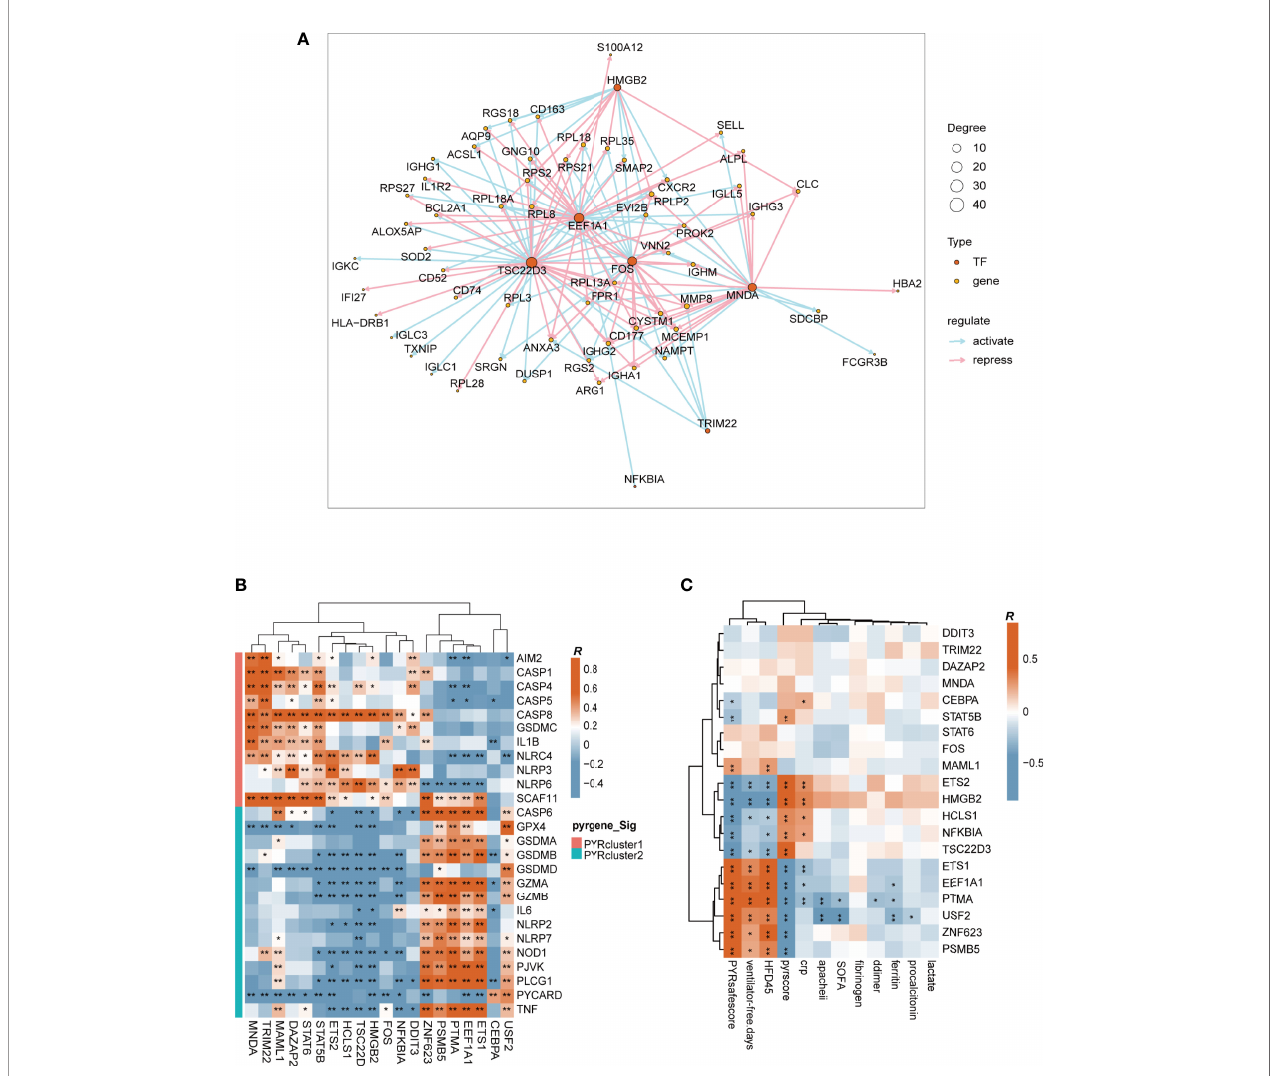
FIGURE 7 | (A) Transcription factors regulatory network of PYRcluster1. “ Degree ” means the number of edges connected to the node. (B) Pearson ’ s correlation of differentially expressed pyroptosis-related genes and transcription factors in PYRclusters; R value represents the Pearson ’ s correlation coef fi cient. Annotation on the left represents in which PYRcluster each pyroptosis-related gene is signi fi cantly highly expressed. (C) Pearson ’ s correlation between different clinical data and transcription factors; R value represents the Pearson ’ s correlation coef fi